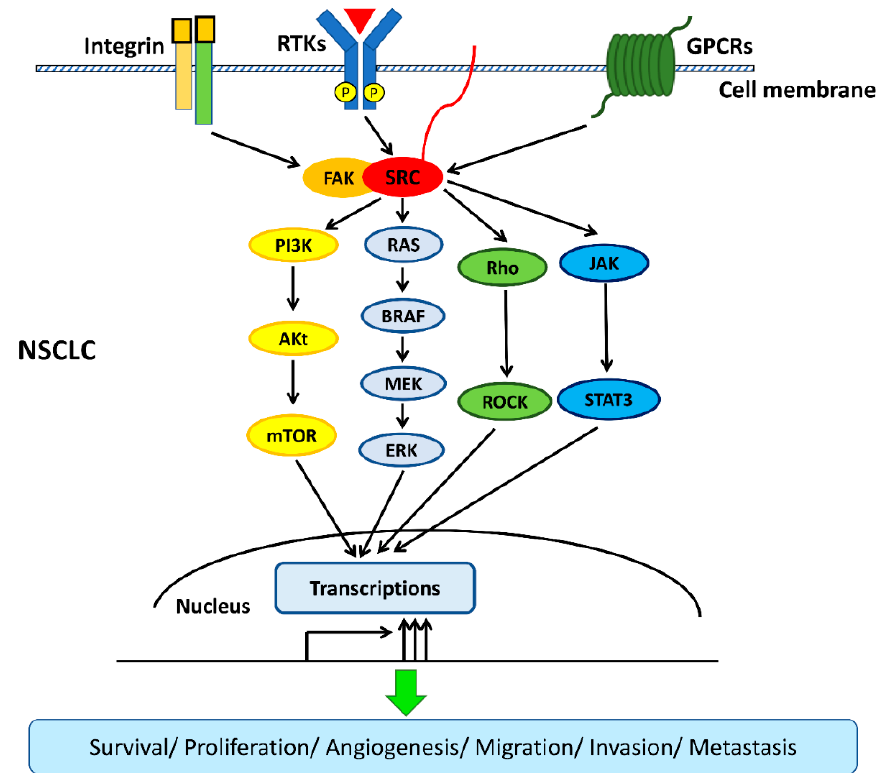
Figure 2. Src interacts with transmembrane cell surface receptors and mediates the transduction of intracellular downstream signaling pathways. Src interacts with transmembrane cell surface receptors, including the integrin/focal adhesion kinase (FAK), the receptor of tyrosine kinases (RTKs), and G-protein-coupled receptors (GPCRs), and then activates downstream signaling pathways. Src activates downstream signaling pathways, including mitogen-activated protein kinase (MAPK)/extracellular signal-regulated kinase (ERK), phosphatidylinositol 3-kinase (PI3K)/Akt/mTOR, interleukin 6 (IL-6)/Janus kinase (JAK)/signal transducer and the activator of transcription 3 (STAT3), and Rho/Rho-associated protein kinase (ROCK) pathways to promote survival, proliferation, angiogenesis, migration, invasion, and metastasis in non-small-cell lung cancer (NSCLC).